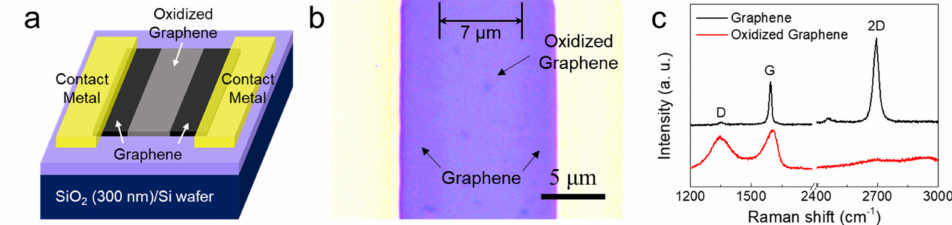
Figure 1. ( a ) Schematic and ( b ) OM image of the graphene/OG heterostructure; and ( c ) Raman spectra of the graphene and